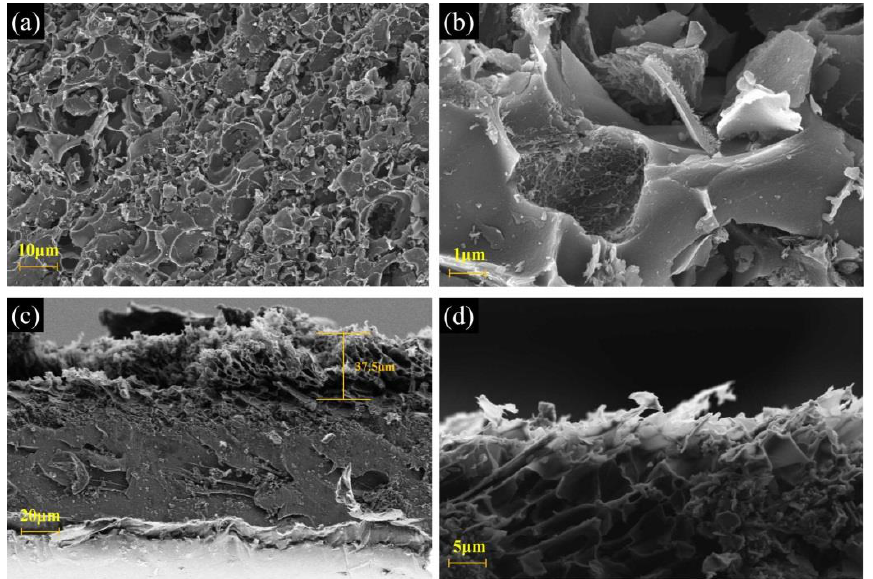
Figure 4. ( a , b ) Top view SEM of 1 wt% Fe 3 O 4 /CNS film, ( c ) sectional view of SEM of 1 wt% Fe 3 O 4 /CNS film, ( d ) high magnification SEM image of the